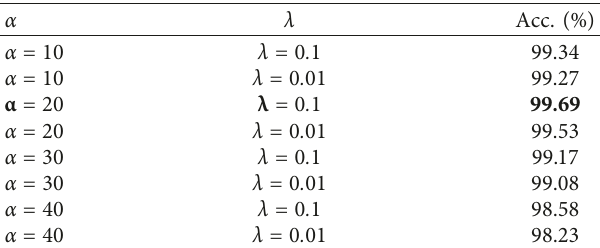
Table 2: Classification accuracy of different hyperparameter on